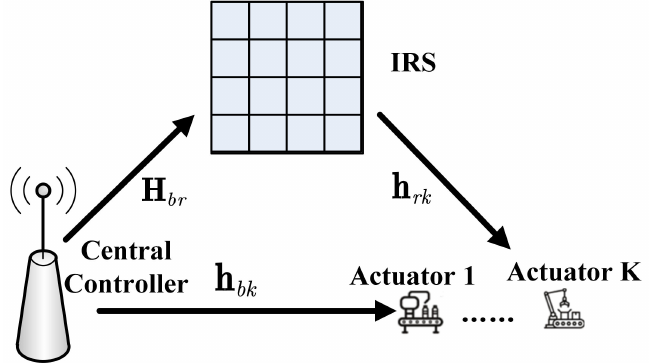
Figure 1. IRS-assisted downlink MU MISO-URLLC system in an IIoT